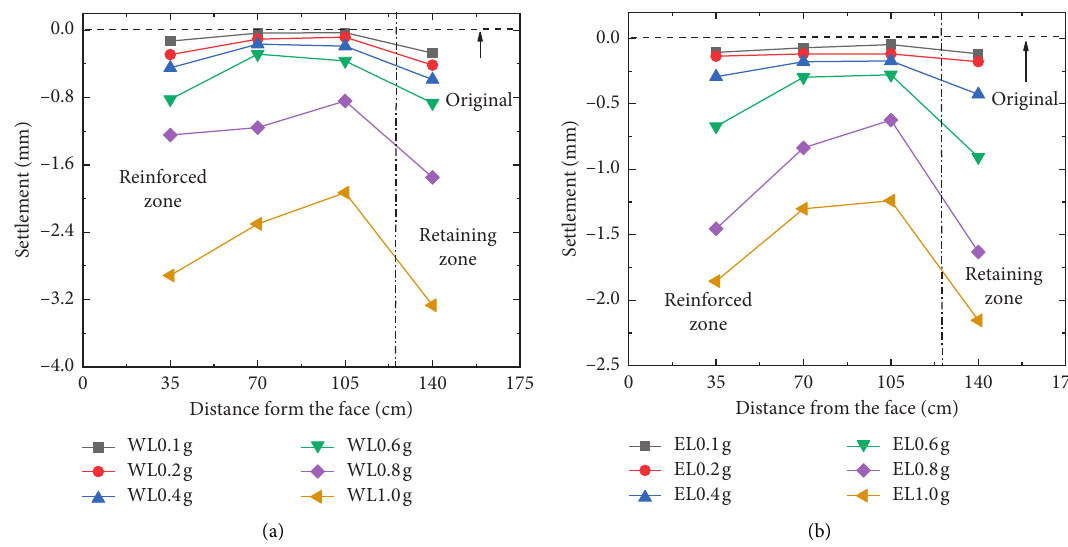
Figure 15: Settlement distributions of the specimen (scale factor: 1/2): (a) WL and (b)